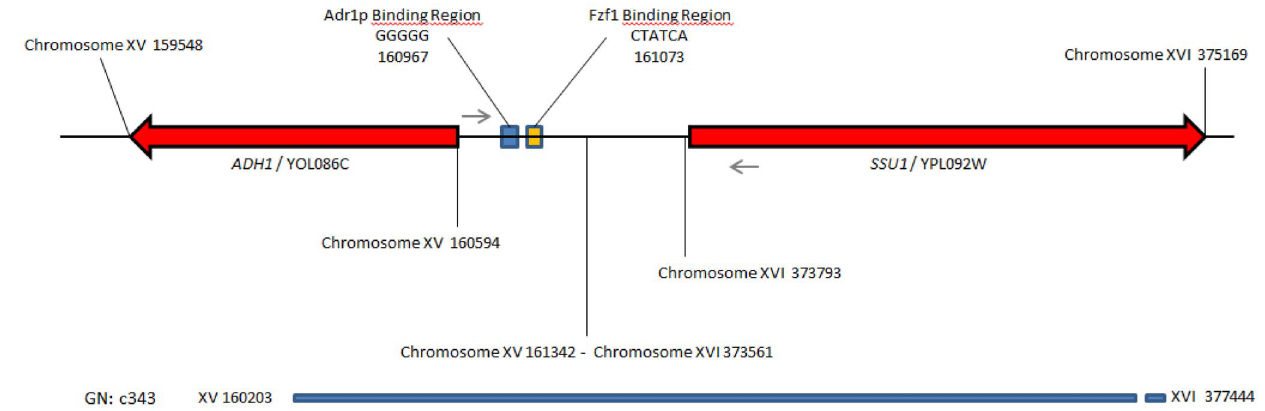
Figure 1. Description of the XV-t-XVI translocation. The diagram represents the breakpoint of translocation XV-t-XVI for the strain GN. The genomic region of contig c343 includes the 5 9 portion of gene ADH1 and the coding sequence of SSU1 (red arrows) and their respective regulating regions Adr1p and Fzf1 binding regions (yellow diamond). The small arrows represent the primers p758 and p761 allowing identifying by PCR the XV- t-XVI translocation.